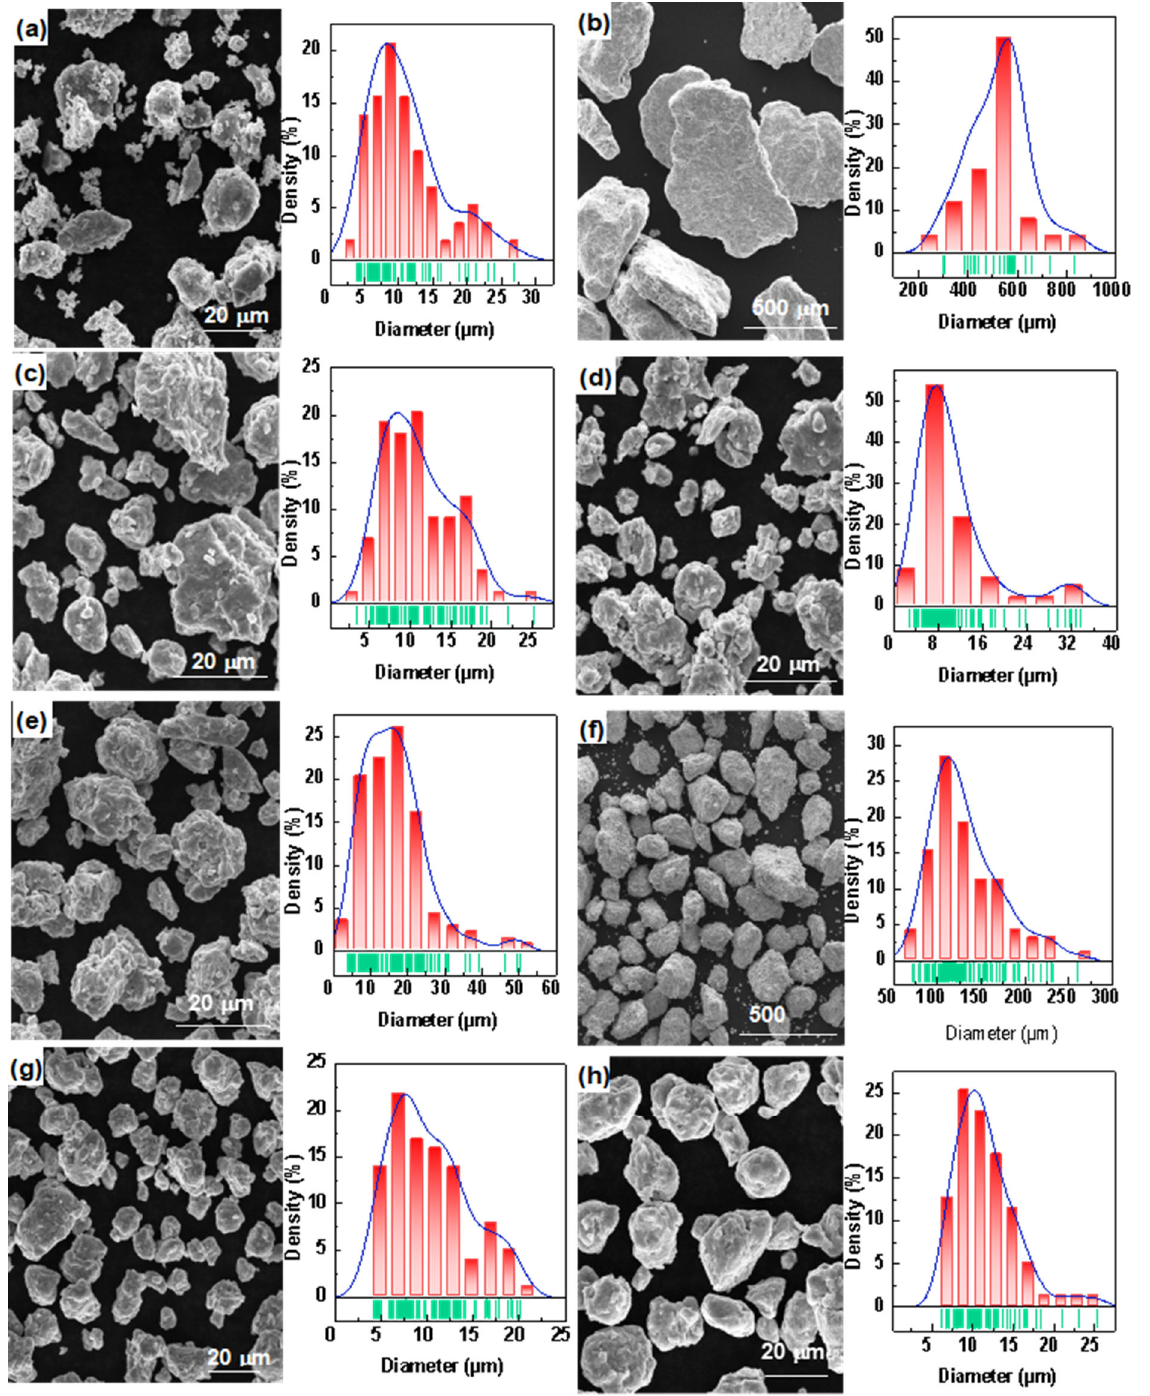
Figure 3. Microstructure morphology and particle size distribution of high ‐ entropy alloys with dif ‐ ferent ball milling times. ( a ) 0.5 h; ( b ) 10 h; ( c ) 20 h; ( d ) 30 h; ( e ) 50 h; ( f ) 70 h; ( g ) 90 h; ( h ) 120 h.